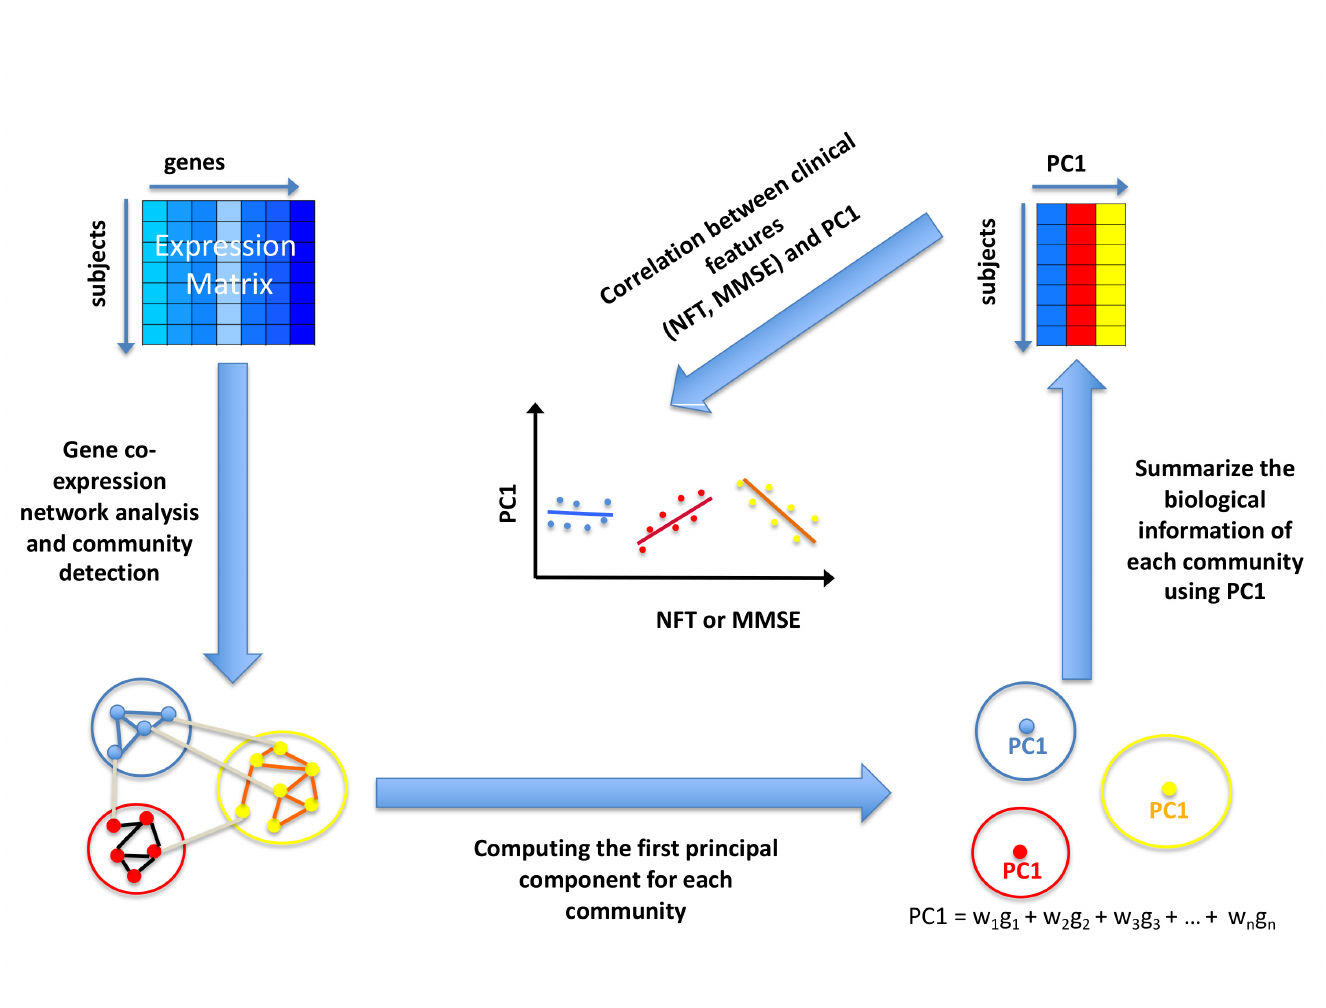
Fig 2. Schematic view of the correlation procedure between module eigengene and clinical features. After the community detection procedure, we computed the module eigengene (first principal component, PC1, of the community) for each found community. Then we implemented a Pearson’s correlation analysis between PC1 and clinical features (MMSE and